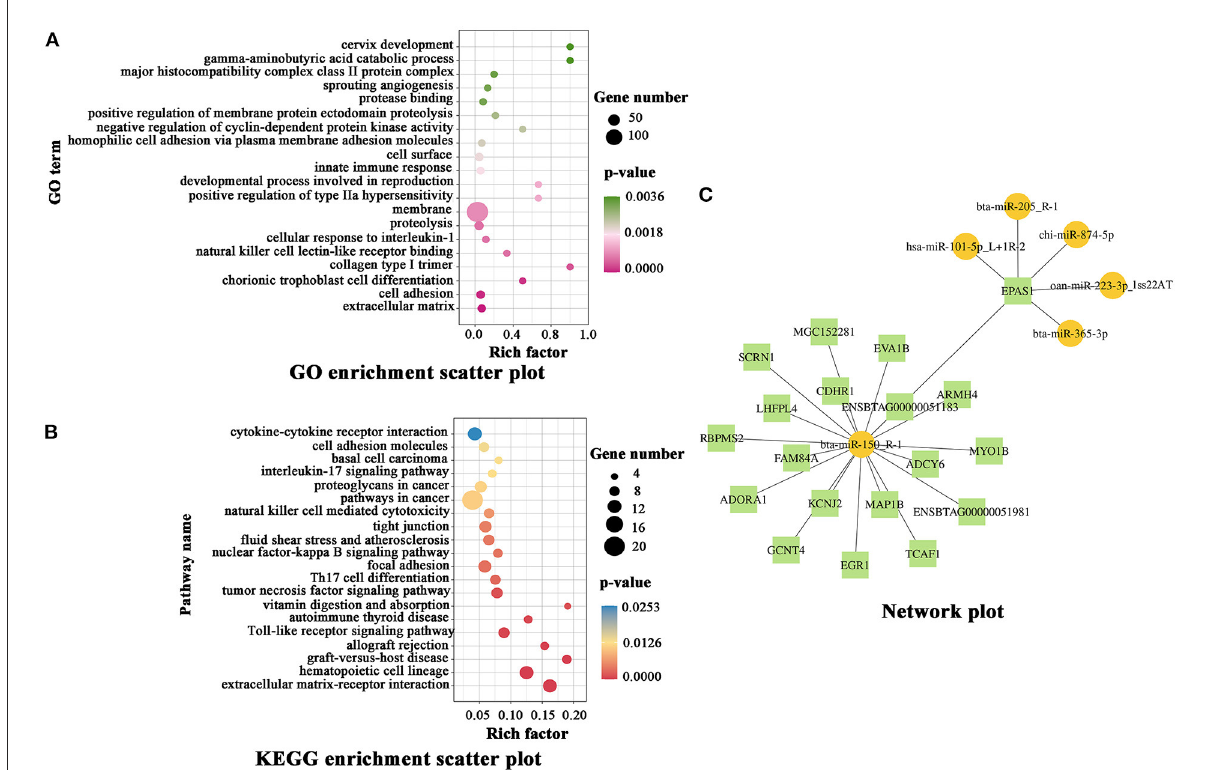
FIGURE3 Functional analysis of DE genes in NC and RP. (A) GO annotation of DE mRNAs. (B) KEGG enrichment analysis of DE mRNAs. (C) miR-150_R-1 and target gene EPAS1 network plot; yellow spheres and green squares represent miRNA and mRNA, respectively; lines represent the interaction between miRNAs/mRNAs. GO, Gene Ontology; KEGG, Kyoto Encyclopedia of Genes and Genomes; NC, fetal membranes of normal discharge; RP, retained